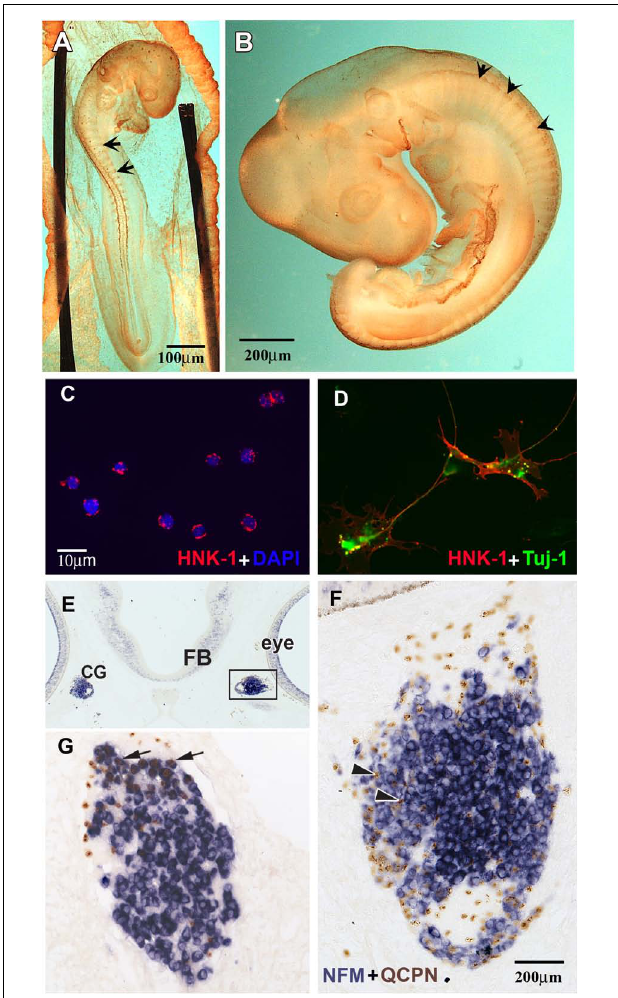
FIGURE 1 | HNK1 identified migrating NCC and forming ganglia. (A,B) Whole HNK1 immunostaining (brown) on HH16 (E2.5, 26–28 somites) and HH19 (E3, 37–40 somites) chick embryos. (A) At HH16, tNCC (arrows) had begun migrating out of the neural tube. (B) By HH19, tNCC were beginning to coalesce into DRG (arrowheads). (C,D) Purified NCC were counterstained with DAPI to reveal all nuclei. HNK1 + cells (red) and DAPI + cells (blue) were counted to calculate the purity of the cell preparation. (D) When purified NCC were cultured overnight, they extended processes and expressed the neuronal marker, Tuj-1. (E–G) Purified quail (QCPN+, brown) NCC were injected into the head mesenchyme of 8–11 somites embryos and harvested 4 days after transplantation. (E) Grafted NCC were able to migrate to their normal targets such as the ciliary ganglia (G) , which are located adjacent to the eye. (F) Higher magnification of the boxed area in E showed that numerous donor cells could be found in the ciliary ganglion 4 days after operation. Most grafted cells incorporated into the ganglion, some of them were either undifferentiated or would become glial cells (arrowheads). (G) A section through the ciliary ganglion from another grafted embryo. Many quail NCC differentiated into NFM + neurons (arrows) while some are non-neuronal or undifferentiated cells.